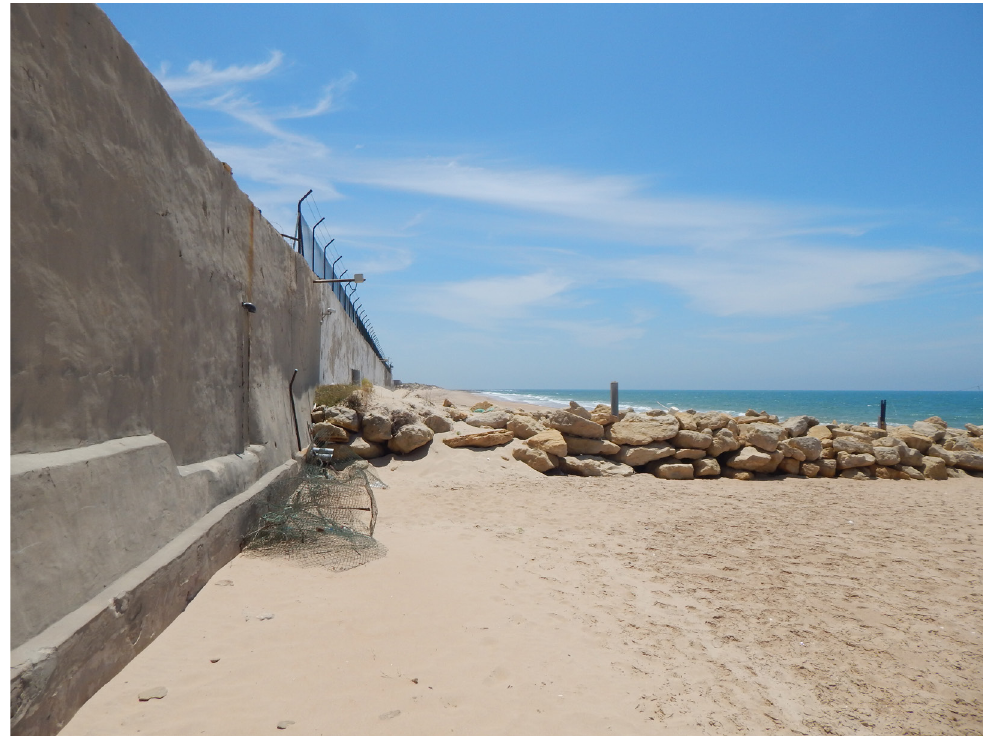
Figure 12. Study of the visibility from Torregorda-point 5. Military enclosure (S.). ©Authors.